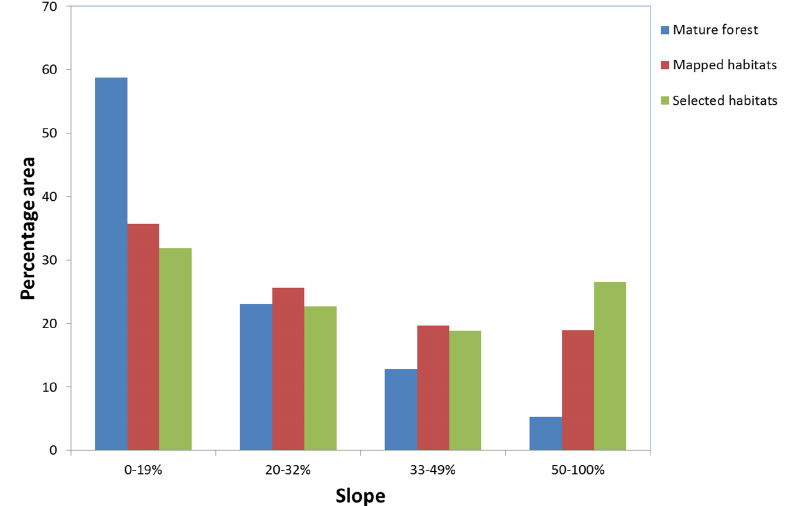
Figure 3. Percentage area of mature forest (development class 5), mapped CHI habitats, and selected CHI habitats in different classes of slope.